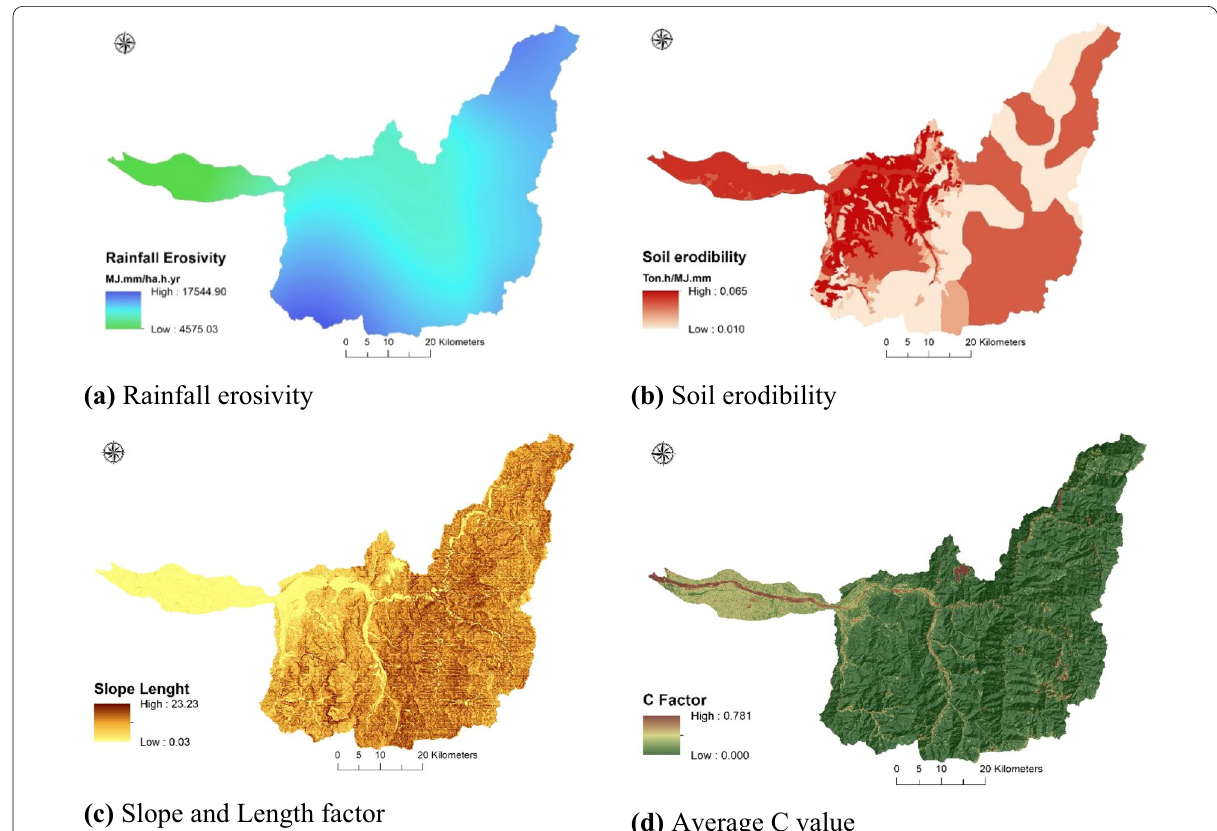
Fig. 4 a Rainfall erosivity, b soil erodibility, c slope and length factor, and d average C